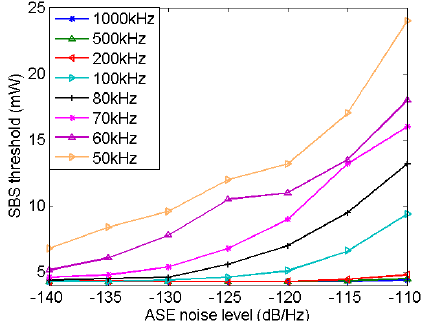
Figure 6. The evolution of the theoretical average SBS threshold versus ASE noise levels with different repetition rates. The pulse duration of the optical pulses is 200 ns.